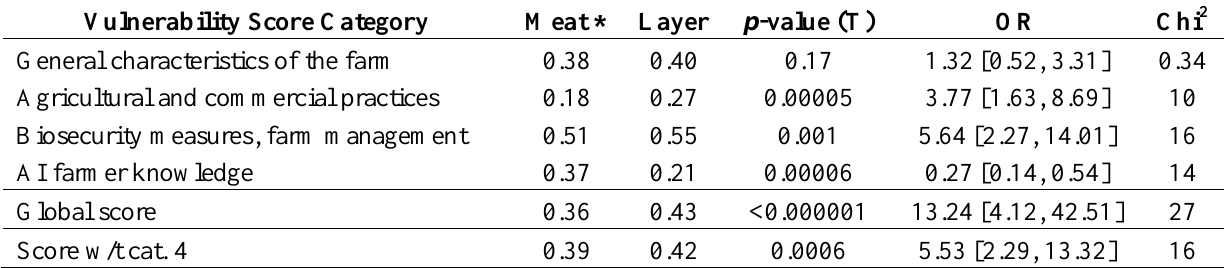
Table 4. Analysis of vulnerability scores by type of production (meat or layer).